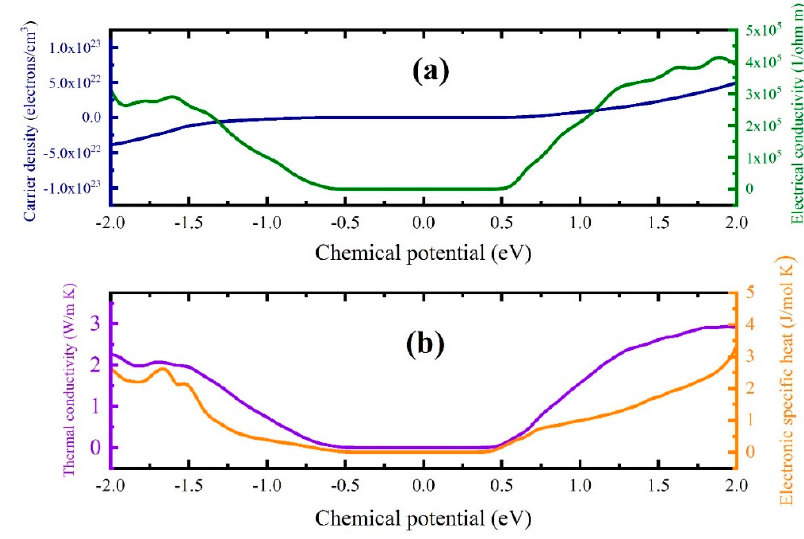
Figure 7. ( a ) Electrical and carrier density as a function of chemical potential. ( b ) Thermal conductivity due to electrons transporting and electronic specific heat versus chemical potential at 300 K.